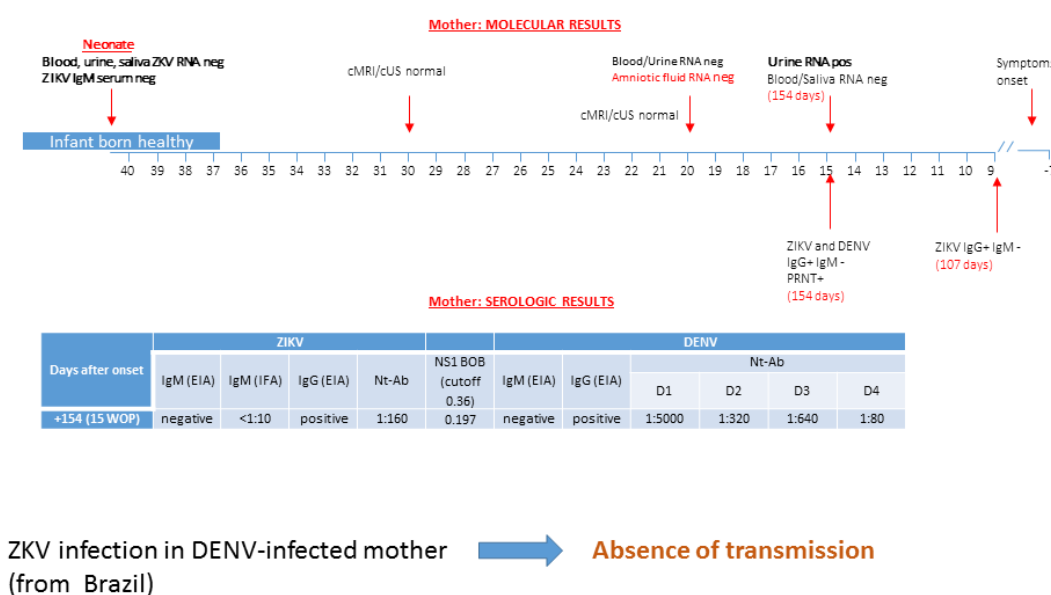
Figure 2. Molecular and serological diagnosis of ZIKV infection performed in a DENV-infected pregnant woman from Brazil is reported. No trasmission was reported. cMRI/cUS: cerebral magnetic resonance imaging/cerebral ultrasonography; PRNT: plaque reduction neutralization test; WOP: week of pregnancy; EIA: enzyme immunoassay; IFA: immunofluorescence assay; Nt-Ab; neutralizing antibodies. In the box of molecular diagnosis, black numbers specify the week of pregnancy, while red numbers in brackets indicate the exact day of gestation. BOB assay result is expressed as the ratio of